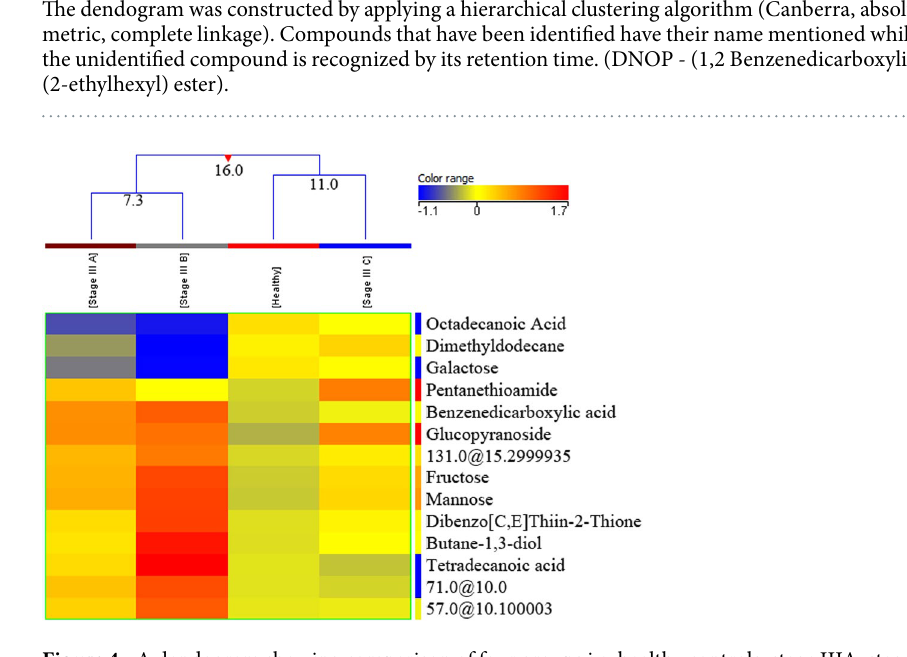
Figure 4. A dendogram showing comparison of four groups i.e. healthy controls, stage IIIA, stage IIIB and stage III C of Breast Cancer patients using normalized intensities of fourteen significant metabolites (p < 0.05). The dendogram was constructed by applying a hierarchical clustering algorithm (Canberra, absolute distance metric complete linkage). Compounds that have been identified have their names mentioned while three of the unidentified compounds are recognized by their retention